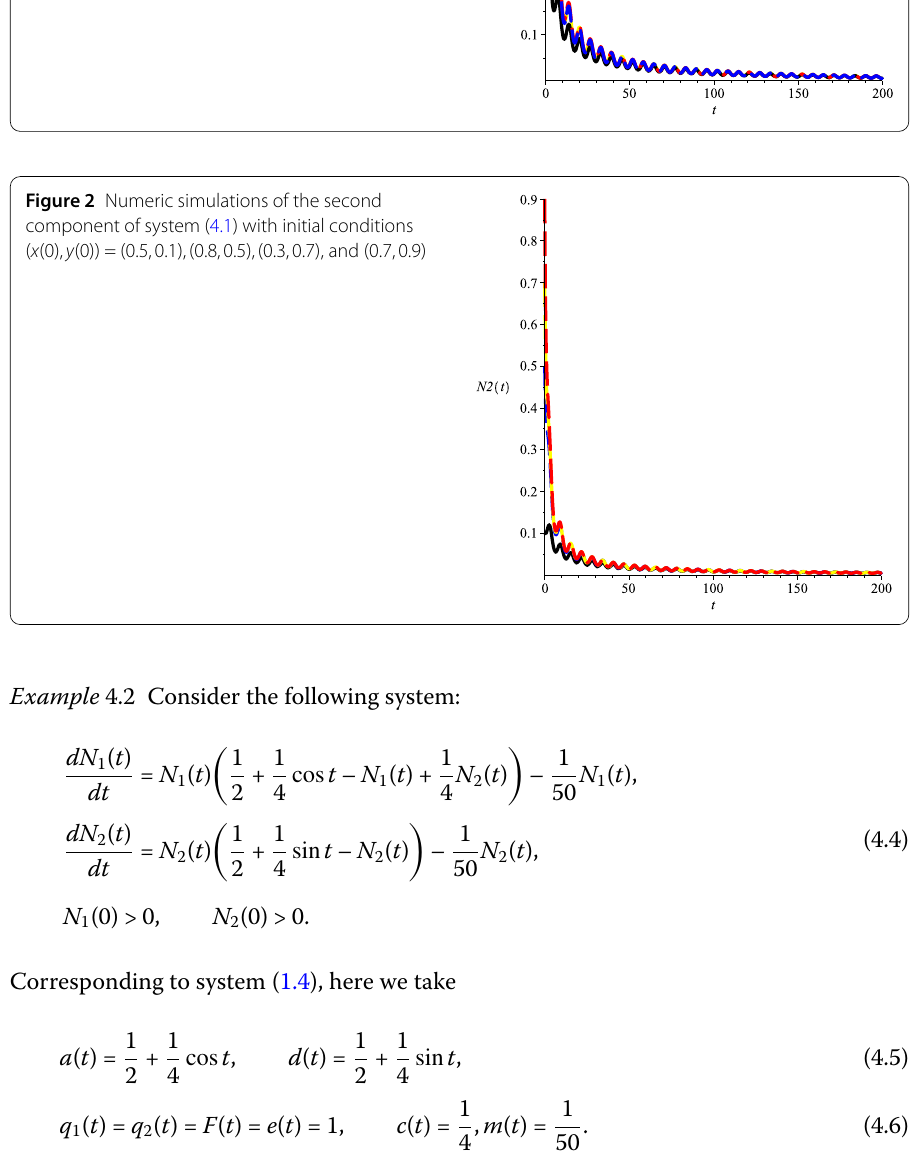
Figure 2 Numeric simulations of the second component of system (4.1) with initial conditions ( x (0), y (0)) = (0.5,0.1),(0.8,0.5),(0.3,0.7), and